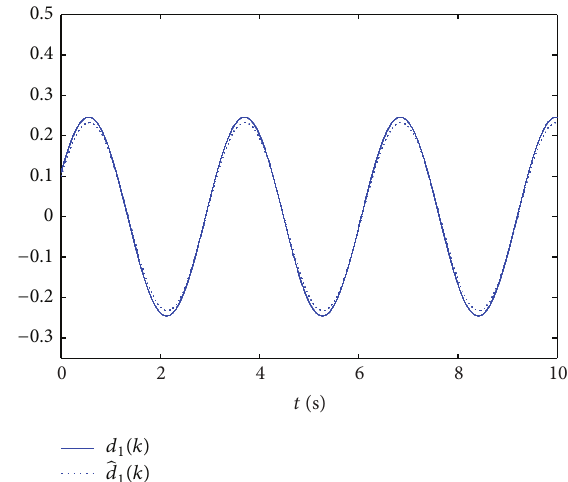
Figure 9: The system state 𝑥 2 (𝑘) .